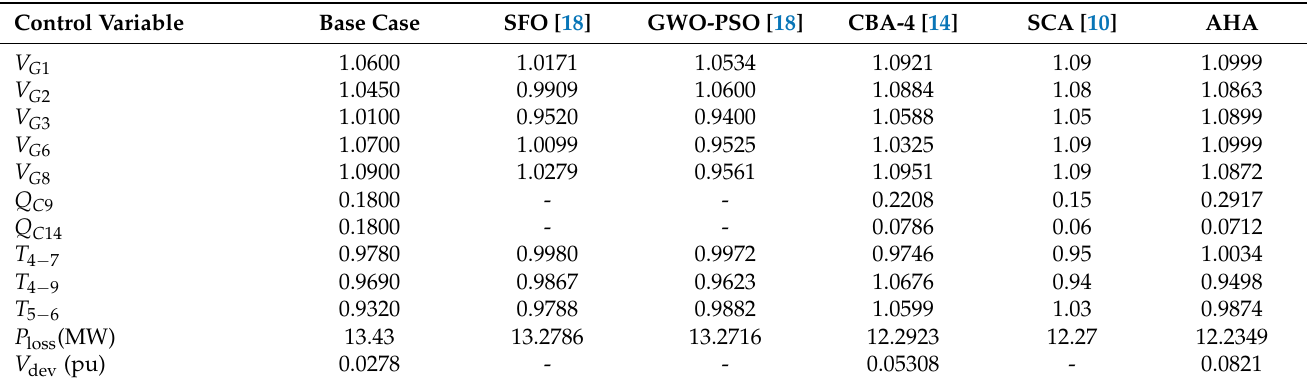
Table 3. Optimal values of control variables with P loss as an objective function for the IEEE 14 bus test